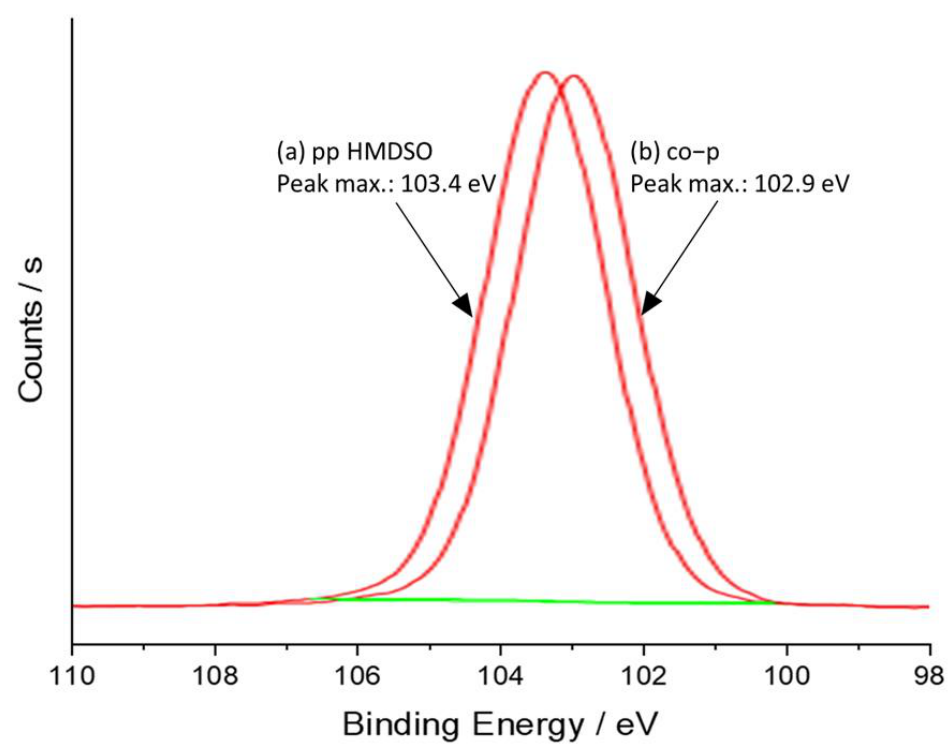
Figure 4. Si 2p high-resolution XPS spectra of (a) ppHMDSO (10 g · h − 1 ); (b) co-p (10 g · h − 1 HMDSO and 10 g · h − 1 lim).